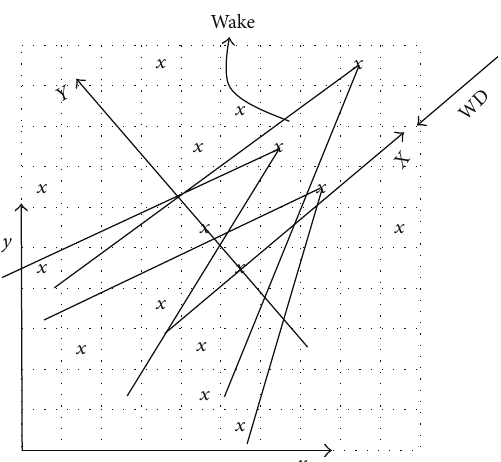
Figure 7: Wind field with relative and global coordinate systems, as well as